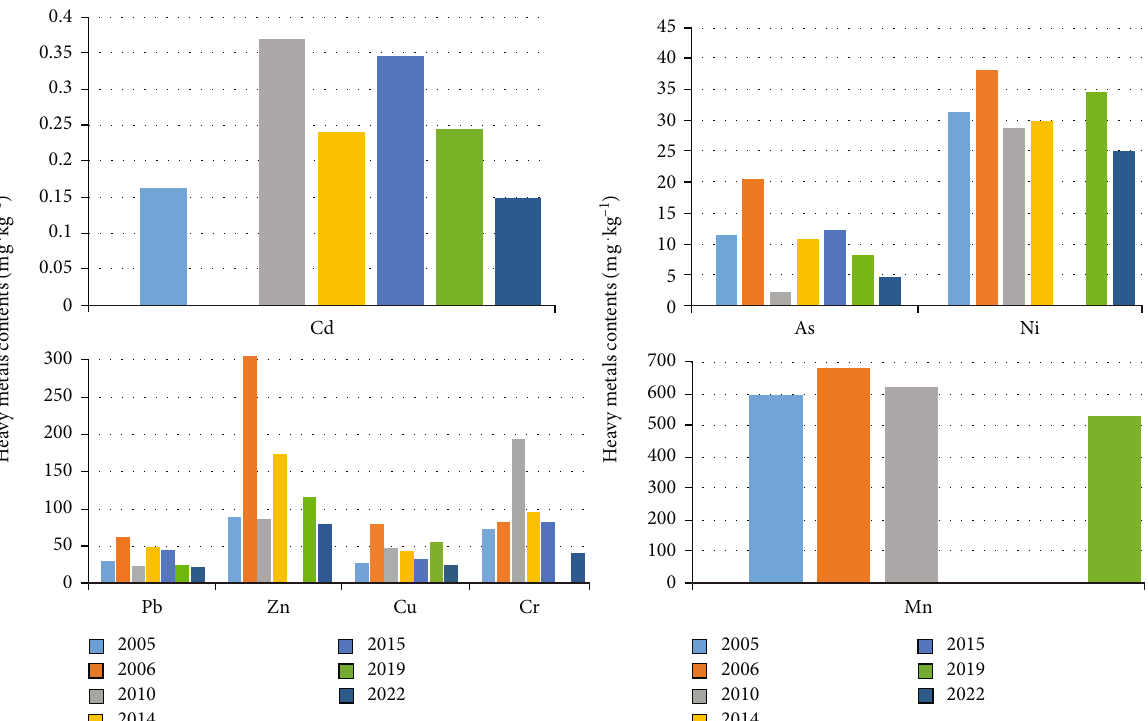
Figure 6: The histogram of the mean values of 8 heavy metals in di ff erent years in Lanzhou